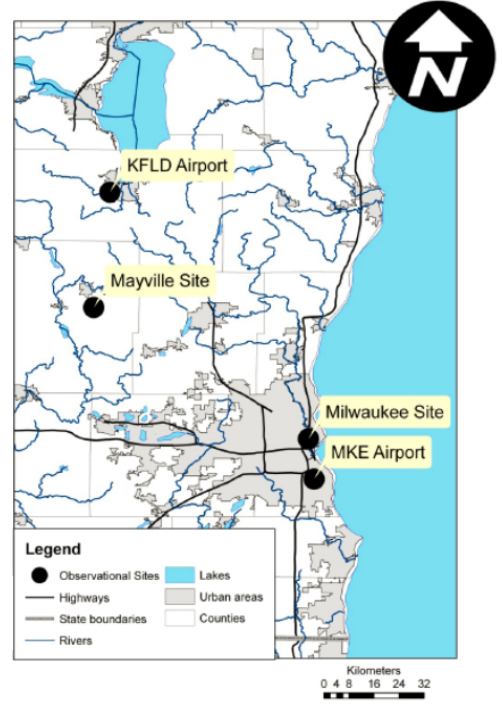
Fig. 1. Area map of WNS sites and meteorological stations KFLD and MKE